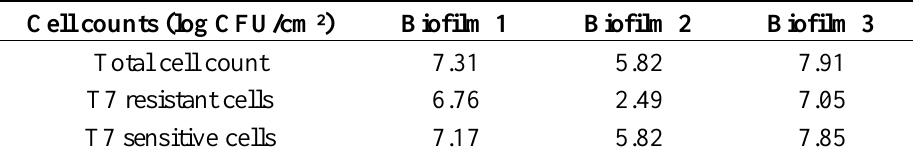
Table 1. Viable cell counts within three mature three-day old E. coli biofilms each exposed once for one hour to ca. 10 8 PFU/mL of T7 phage, followed by three additional days of growth before